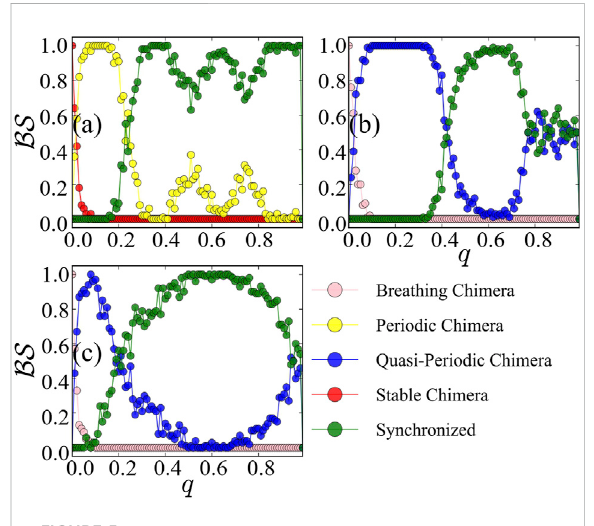
Basin stability BS of different states of the original system, with respect to the percentage q of the perturbed nodes of two populations. The coupling disparity is set by A = 0.20 in (A) , A = 0.28 in (B) , and A = 0.35 in (C) . The emerged states include breathing chimera (in pink), periodic chimera (in yellow), quasi- periodic chimera (in blue), stable chimera (in red), and synchronized (in green). Initially, the system is in the region of stable chimera (A) and breathing chimera (B,C) as predicted by the low-dimensional model. For the simulation, we set β = 0.1, M q = 100 and N σ = 128.